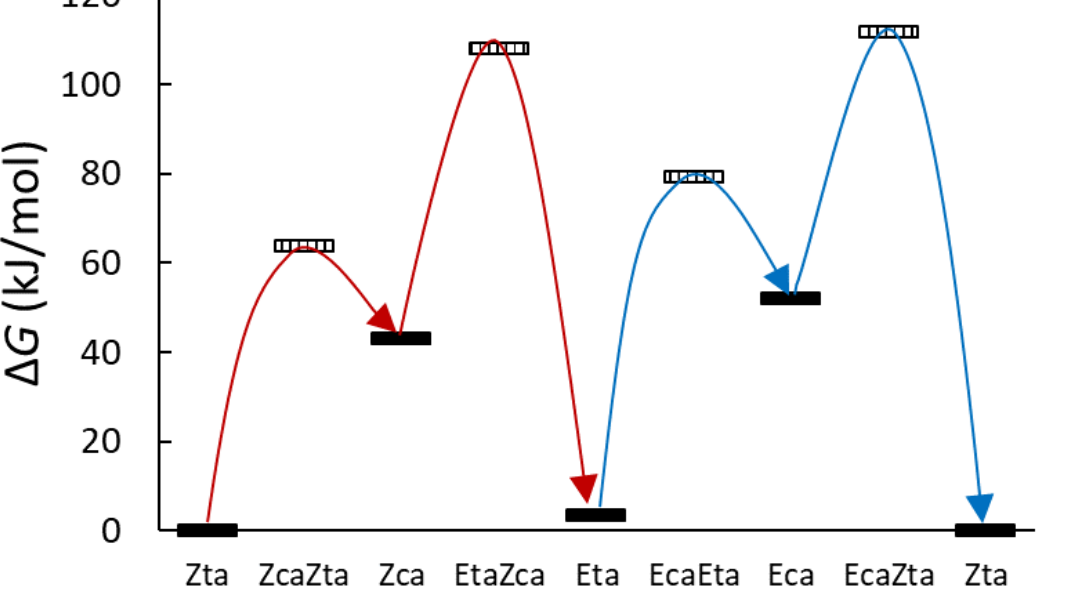
Figure 17. Energetics of the shortest paths for the interconversion between 1 -Zta and 1 -Eta comprising an umklapp ( Φ ) and a θ isomerization step. Solid bars indicate minimum energy isomers and hatched bars indicate transition states. The fast pathways are indicated by curved arrows.